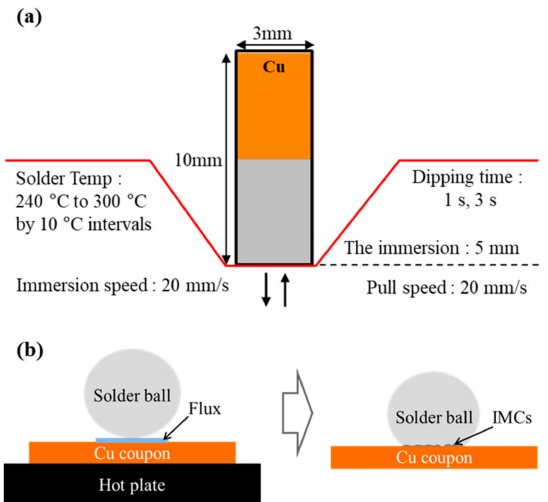
Figure 1. Schematic of the ( a ) dipping test and ( b ) ball shear test sample.